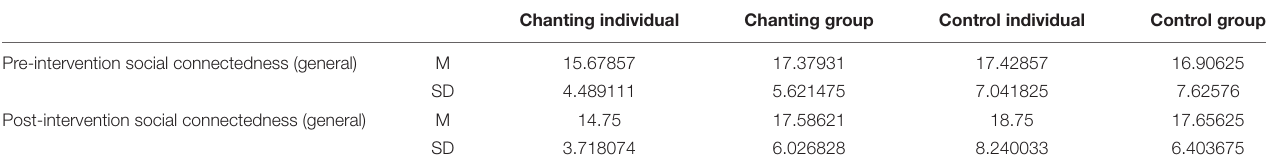
TABLE A2 | Social connectedness (general).